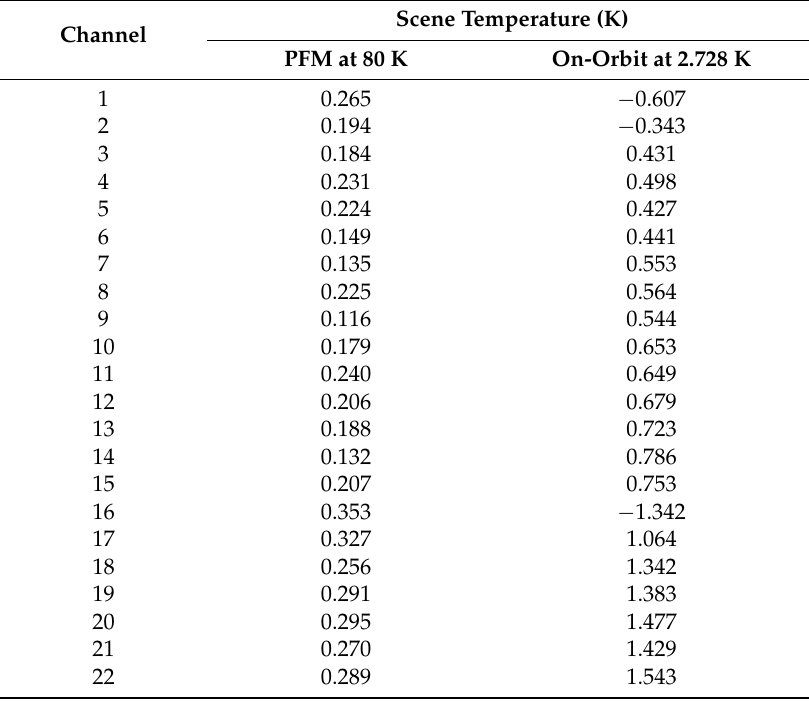
Table 6. On-orbit calibration accuracy derived from pitch maneuver data compared with those from the PFM error budget model at the cold scene. The pitch maneuver data at the center location is compared with the truth (2.728 K) for defining the on-orbit calibration accuracy. Scene Temperature (K) Channel PFM at 80